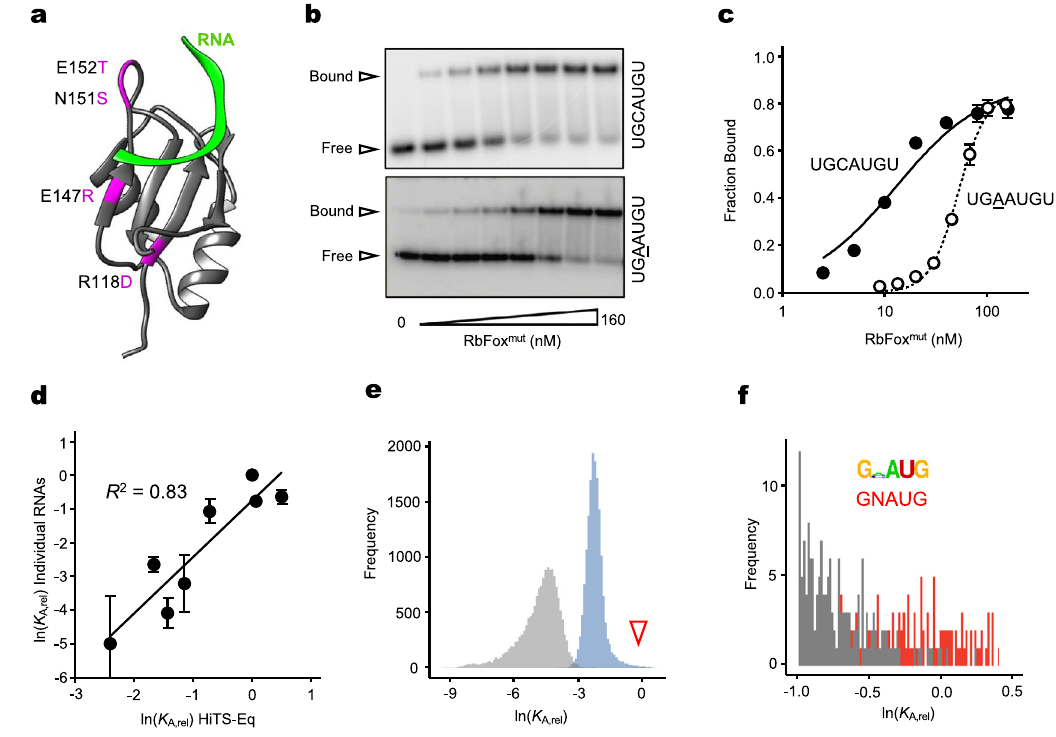
Fig. 3 | Impact of RbFox mutations on the af fi nity distribution. a Locations of the mutations in RbFox mut in the RRM 20 , highlighted in purple(green band:RNA 5 ’ - UGCAUGU 19 ). b Representative PAGE images for RbFox mut equilibrium binding to individualRNAsubstrates(sequencesontheright;RbFox mut :0,2.5,5,10,20,40,80 and160nMforbothsubstrates;RNAs:1nM).Theexperimentswererepeatedthree times with similar results. c Equilibrium binding isotherm for RbFox mut with the substrates shown in panel b (data points: average of three independent experi- ments; error bars: one standard deviation; lines: best fi t to binding isotherm; K 1 = 2 ð UGCAUGU Þ =14.3±2.5nM, K 1 = 2 ð UGAAUGU Þ =35.3±11.8nM). d Relative apparent association constants ( K A,rel ) for corresponding RNA variants (for sequences, see